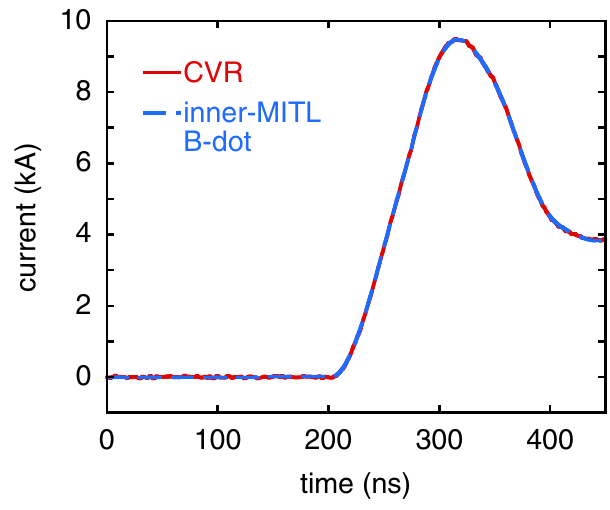
FIG. 7. (Color) Result of the calibration of an inner-MITL B -dot current monitor. The reference current is that measured by a current-viewing resistor (CVR). The normalized standard devia- tion of the pointwise difference [Eq. (12)] between the two current-pulse shapes is less than